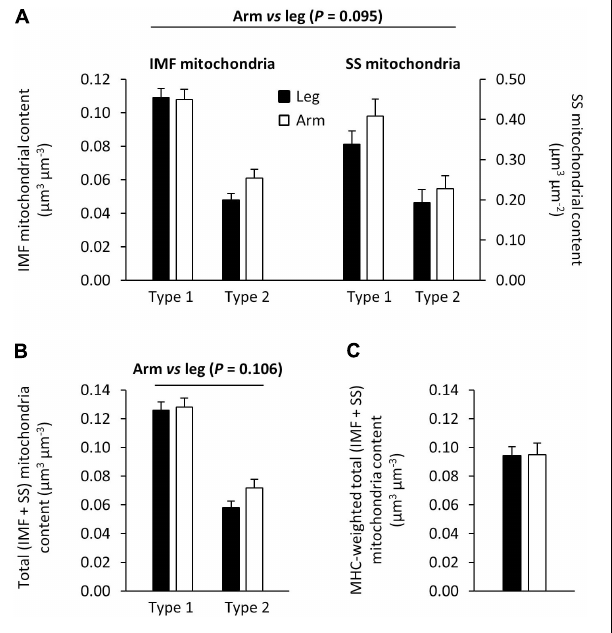
FIGURE 3 | Mitochondria content and subcellular localization in distinct fiber types and at whole-muscle level of leg and arm muscles. There was a tendency ( P = 0.095) toward a higher mitochondrial content in the intermyofibrillar (IMF) and subsarcolemmal (SS) regions, of arm muscle (open bars) compared with leg muscle (filled bars) (A) . This tendency is also apparent when calculating total mitochondrial content (IMF + SS) (B) . (C) Weighted mitochondrial volumes in the arm and leg muscle, estimated from a fiber type distribution of 57 and 37% MHC-I for the leg and arm ( n = 9), respectively. These MHC weighted values of whole-muscle mitochondrial content in arm and leg muscles are similar. Values are means ± SE ( n = 29–30 fibers from 10